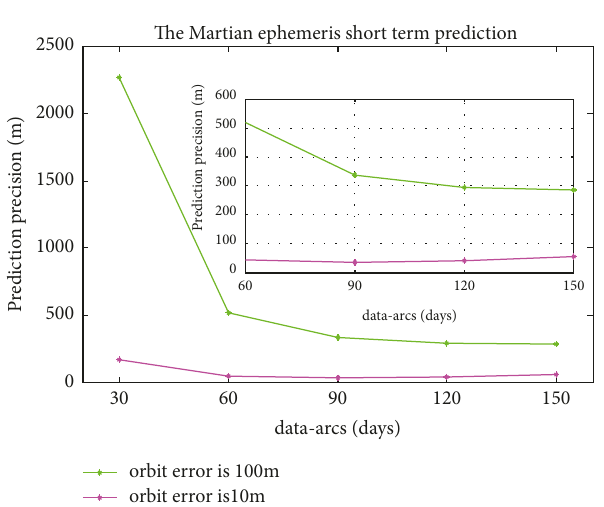
Figure 7: The Martian ephemeris short-term prediction with different probe orbit